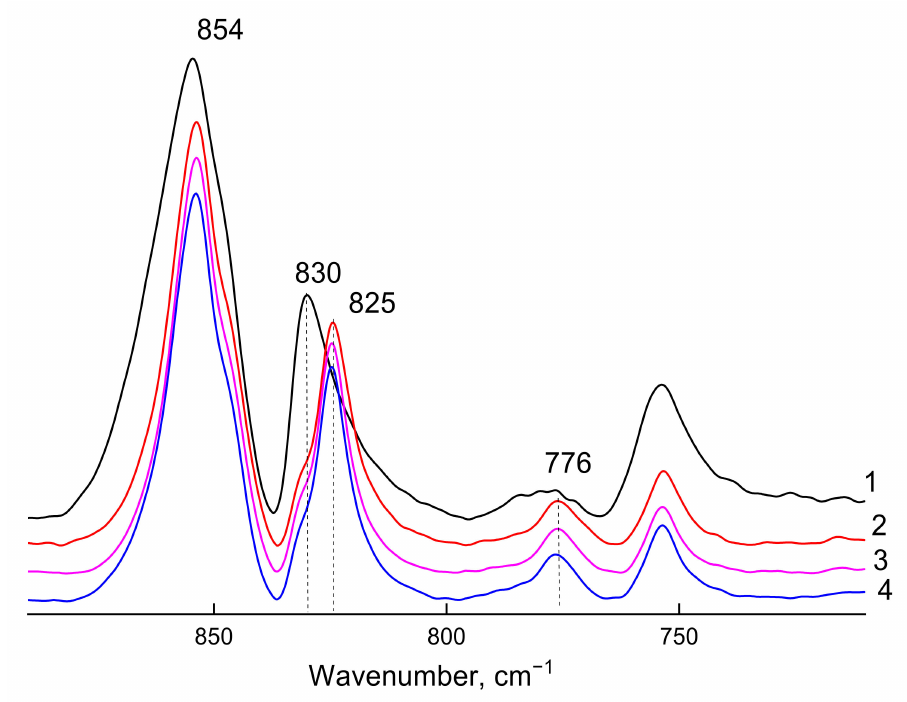
Figure 3. Fragments of ATR-FTIR spectra of PPO-2/50 ◦ C (curve 1), PPO-1 (curve 2), PPO-4 (curve 3), and PPO-2 (curve 4) films in the vibrations absorption region characterizing the amorphous and crystalline phases (ZnSe